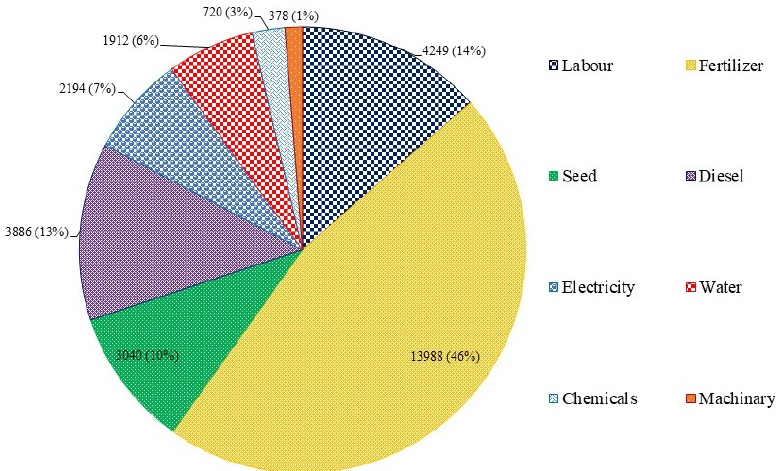
Figure 3. Source-wise energy input under different tillage and irrigation management Figure 3. Source ‐ wise energy input under different tillage and irrigation management practices.